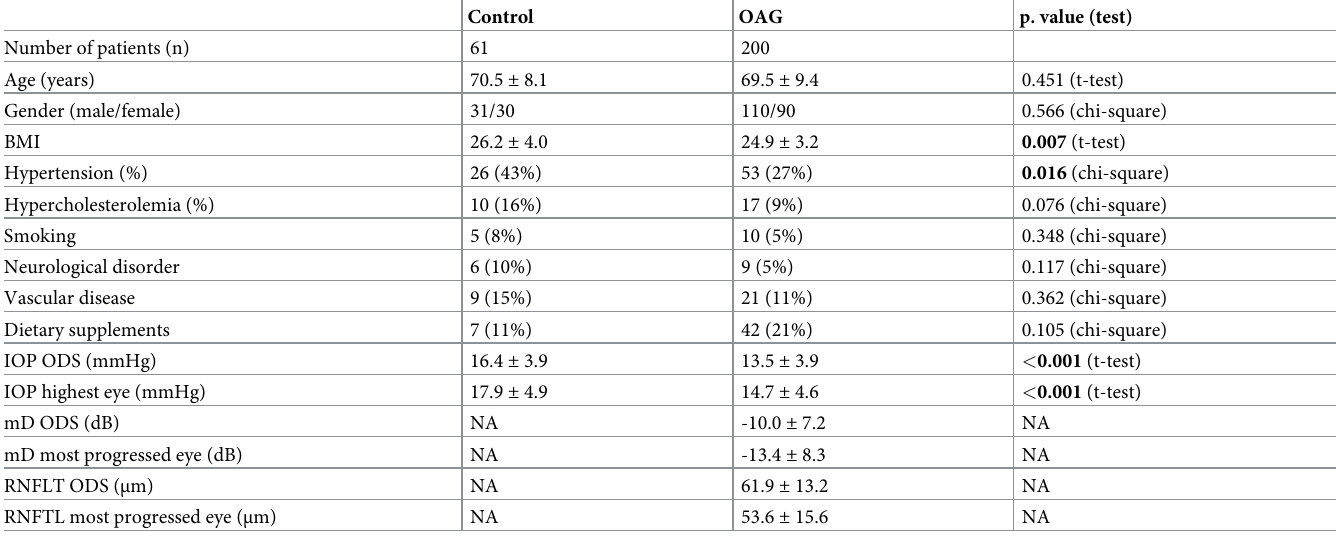
Table 1. Characteristics of OAG patients and